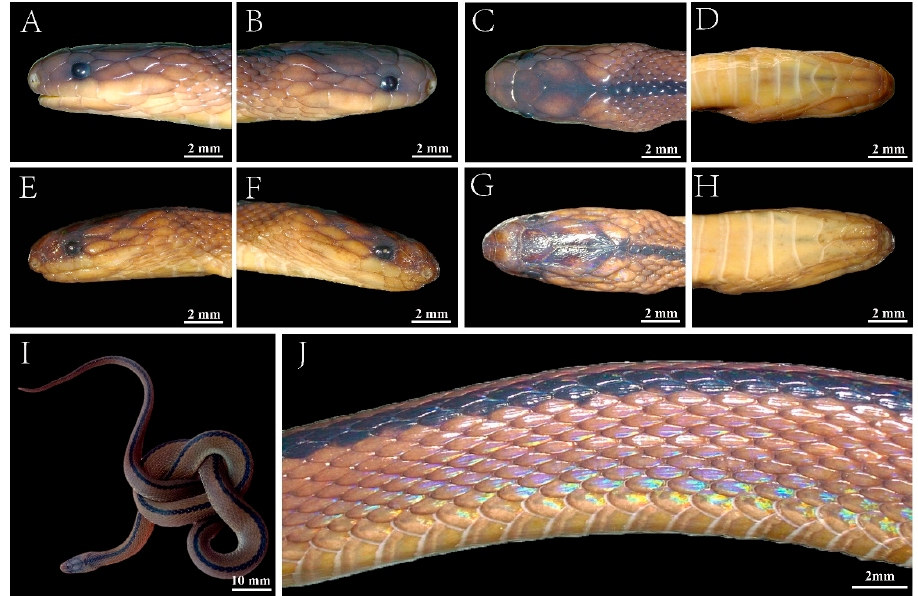
Figure 3. The general aspect of the adult female holotype (AHU 2018-EE-0710) and the adult male paratype (AHU 2016-EE-0615) of Achalinus dabieshanensis sp. nov . ( A – D) the holotype left and right and dorsal and ventral view of head (showing length of the suture between internasals shorter than it between prefrontals, a single loreal, six supralabials, five infralabials and temporals 2 + 2 + 3); ( E – H ) the paratype left and right and dorsal and ventral view of head; ( I ) Overall view of the preserved holotype; ( J ) the holotype dorsal view of midbody (showing dorsum iridescent brown with three scales wide dorsal black line). Photos by Lihua Huang and Caiwen Zhang.